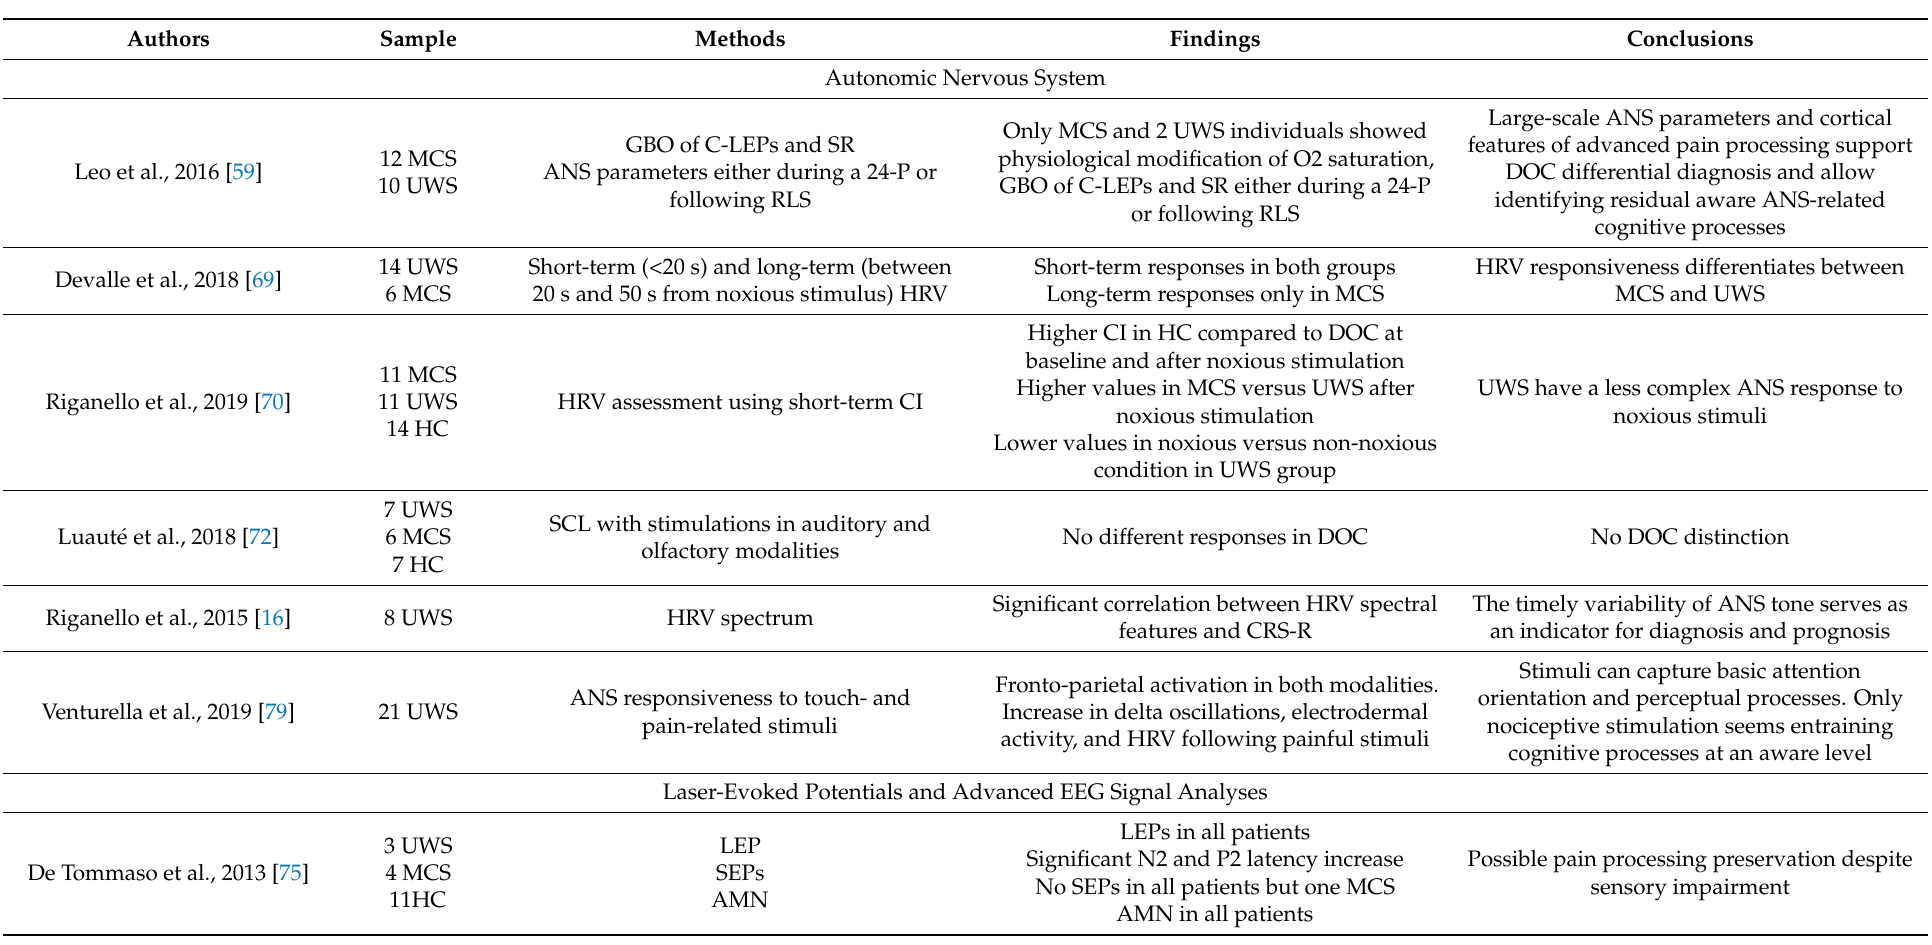
Table 1. Main neurophysiological studies investigating pain perception in patients with disorders of